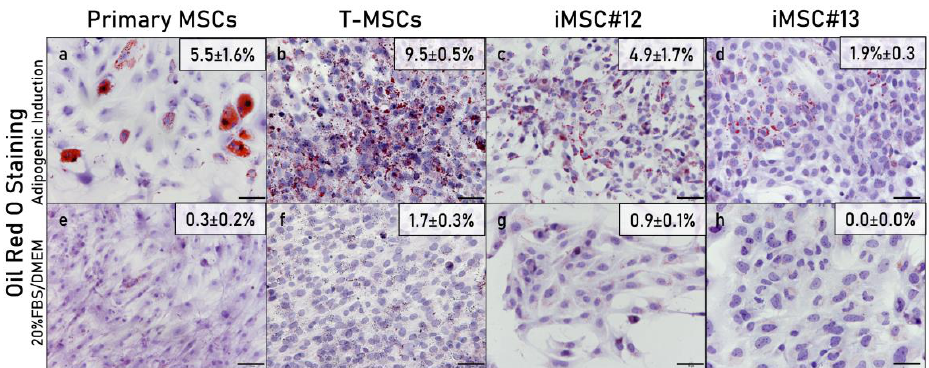
Figure 5. Adipogenic potential analysis of primary MSCs, T-MSCs and iMSCs #12 and #13 after 3 weeks cultured in adipogenic medium ( a – d ) or grown in control medium (20%FBS/DMEM) ( e – h ). For each sample, the average percentage of the area stained with Oil Red O is indicated. Information from primary MSC#13 and T-MSC#13 was not acquired because of cell number restrictions, and therefore only primary MSC#12 and T-MSC#12 are shown. Scale bar: 50 µm.